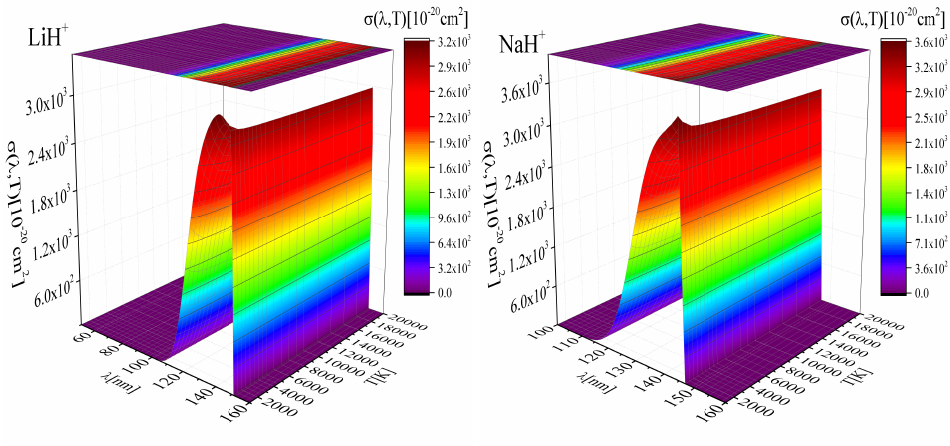
Figure 2. Left : A surface plot of the averaged cross-section σ ( λ , T ) for photodissociation of the LiH + molecular-ion, as a function of λ and T ; Right : A surface plot of the averaged cross-section σ ( λ , T ) for photodissociation of the NaH + molecular-ion, as a function of λ and T .